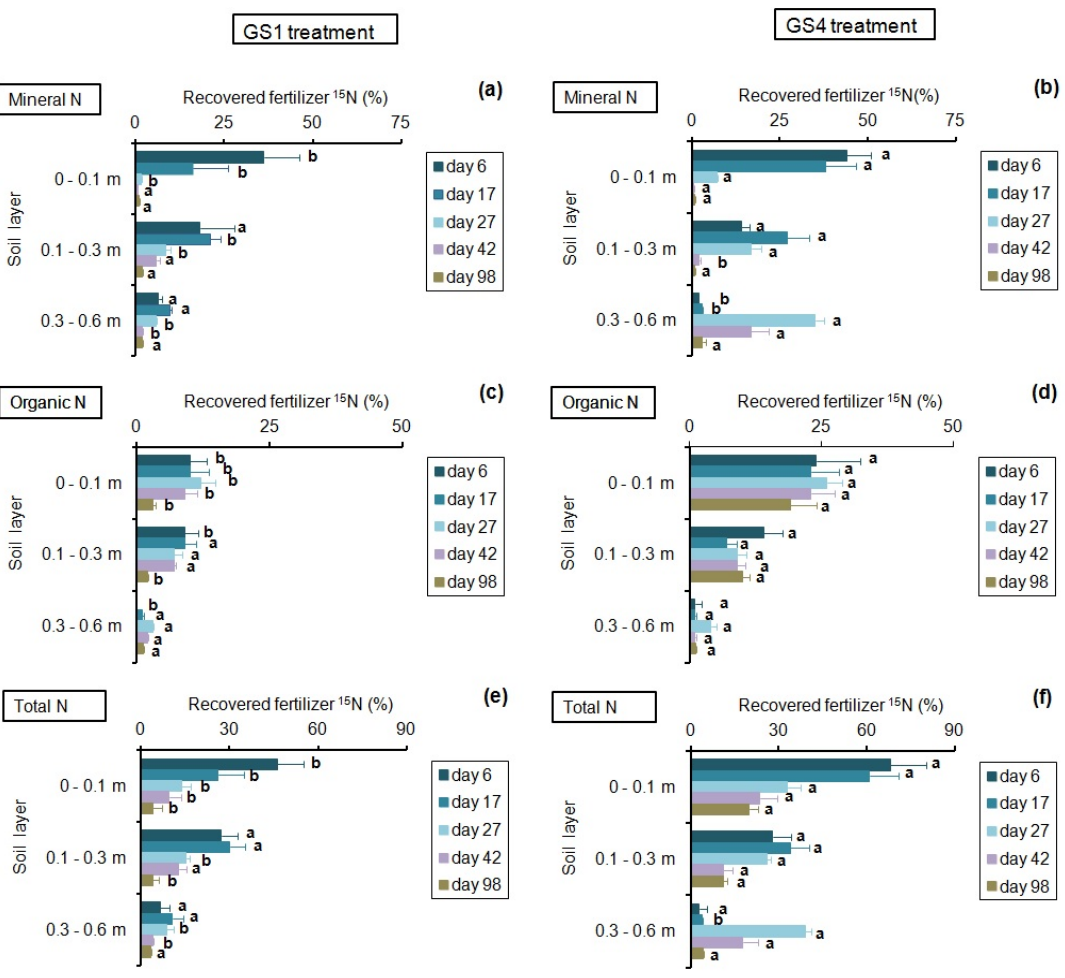
Figure 4. Fraction of the fertilizer 15 N recovered as mineral, organic, and total N (mineral + organic) in the different soil layers as a function of the time after fertilizer application. GS1 and GS4 refer to the first and the fourth growing seasons, respectively. Horizontal bars indicate the standard deviation (n = 8). For each sampling date and soil layer, different letters indicate significant differences between treatments ( p ≤ 0.05).